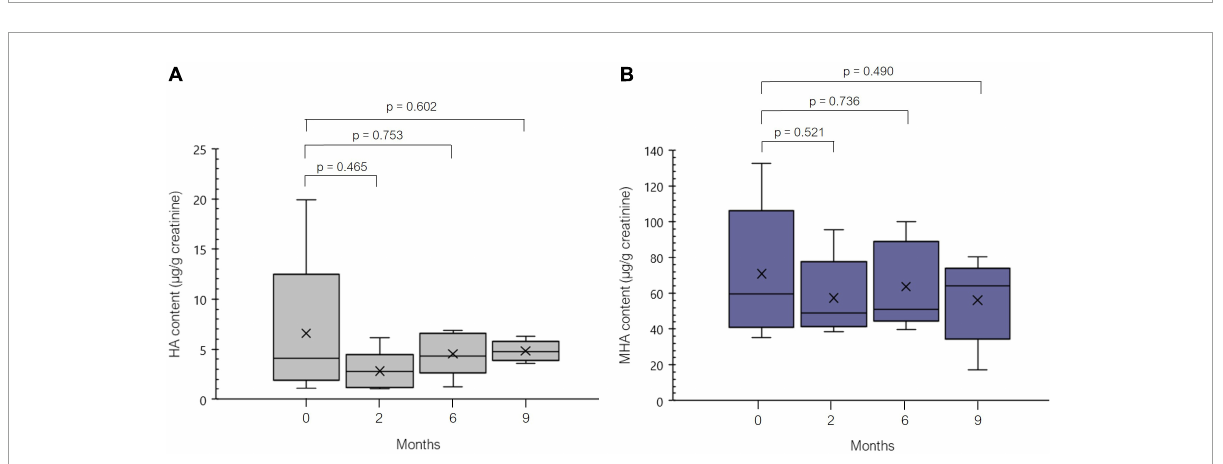
FIGURE4 Distribution of the levels of ( µ g/g creatinine) of histamine (HA, A ) and 1-methylhistamine (MHA, B ) during 9 months of dietary treatment (low-histamine diet and DAO enzyme supplementation) in five